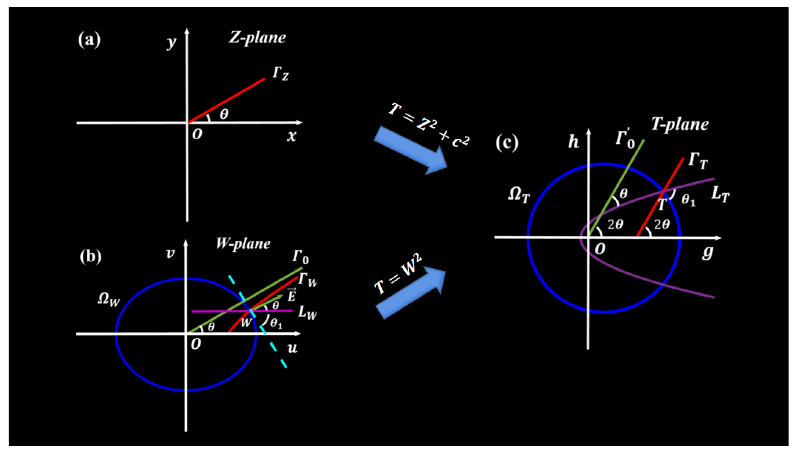
Figure A1. Conformal mapping between any two of Z -plane ( a ), W -plane ( b ), and T -planes ( c ). Continuing in Figure A1b, we selected an arbitrary point on Γ W and denoted it as W